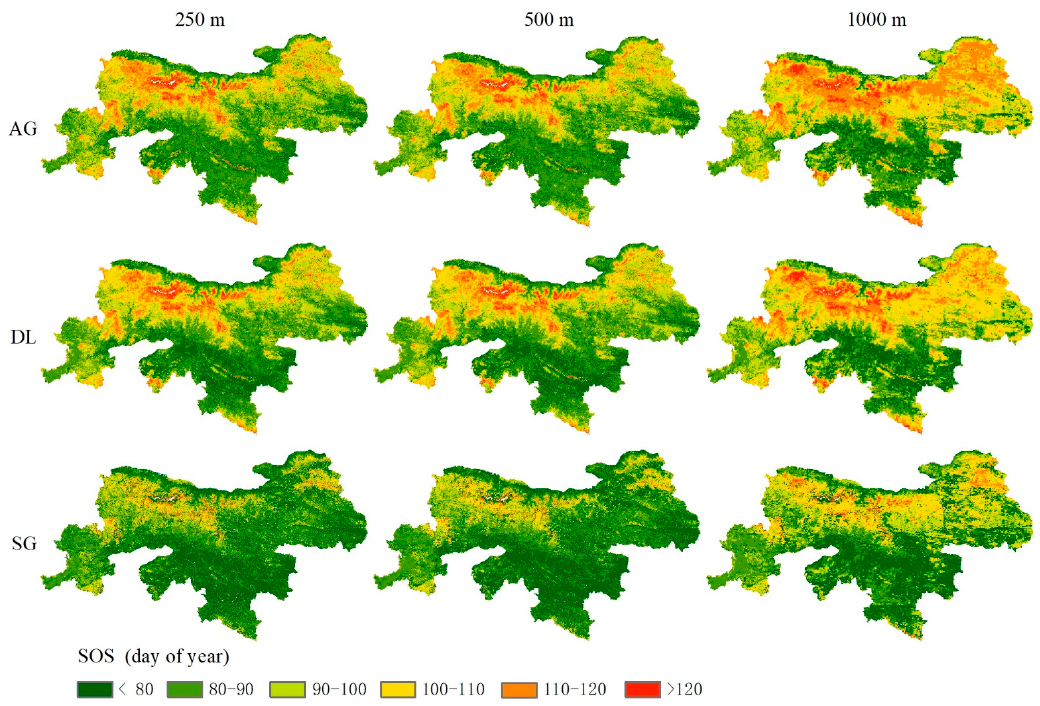
Figure 6. Start of season (SOS) in 2018 retrieved from three different NDVI datasets (MOD13Q1, MOD13A1, and MOD13A2) and pre-processed with three different filters (SG, Savitzky-Golay; AG, asymmetric Gaussian; DL, double logistic).